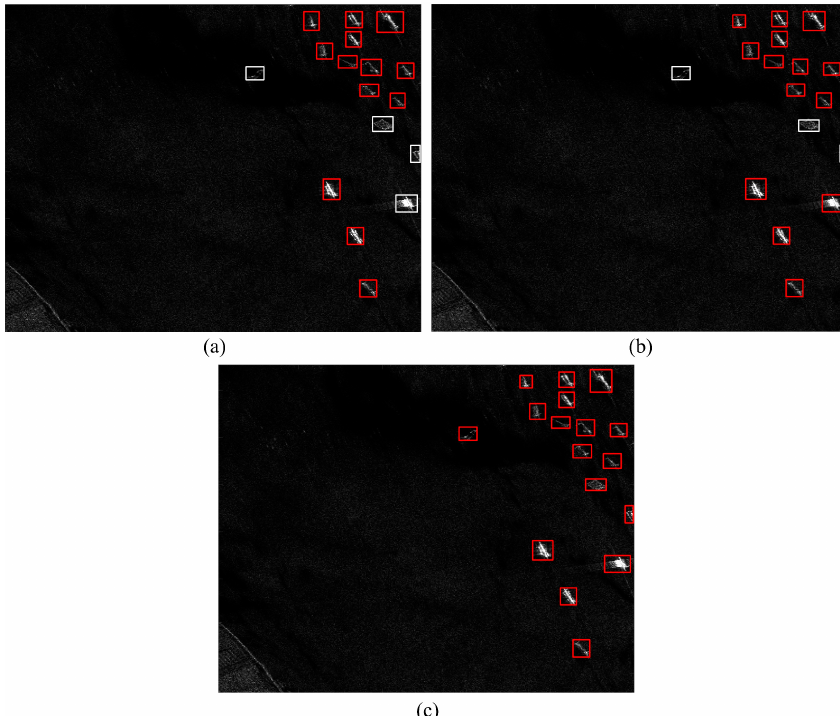
Figure 12. The detection results. ( a ) Yolo_v3 result. ( b ) Densely-faster-RCNN result. ( c ) Proposed method. The red, white, and green rectangles represent the correct detection ships, the missing ships, and the false alarms, respectively.